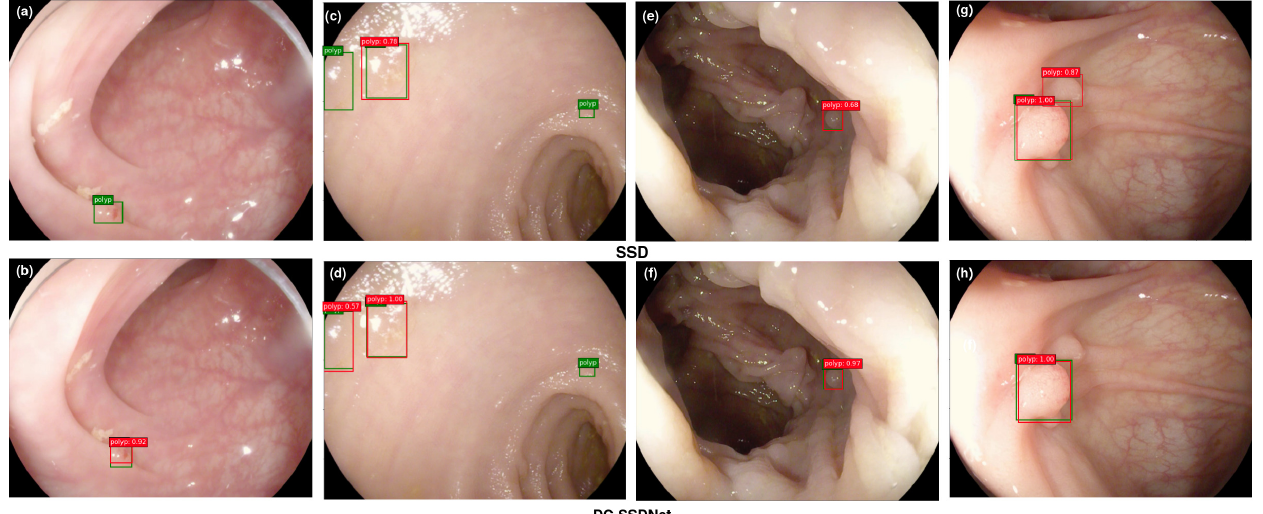
Figure 9. On the Etis-Larib test set, visualization results comparing SSD300 ( a , c , e , g ) and the proposed DC-SSDNet network ( b , d , f , h ). True bounding boxes with IoU of 0.5 or greater are drawn in green, whereas predicted bounding boxes are in